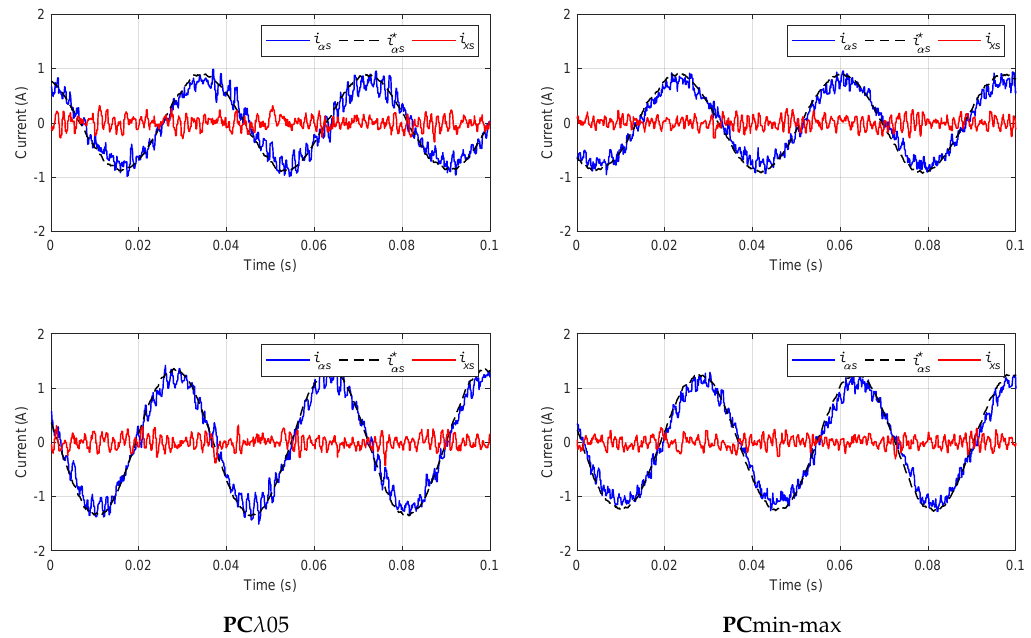
Figure 4. Experimental comparison of the proposed controller ( right ) against a traditional FCSMPC ( left ) at two operating regimes ( top and bottom rows).